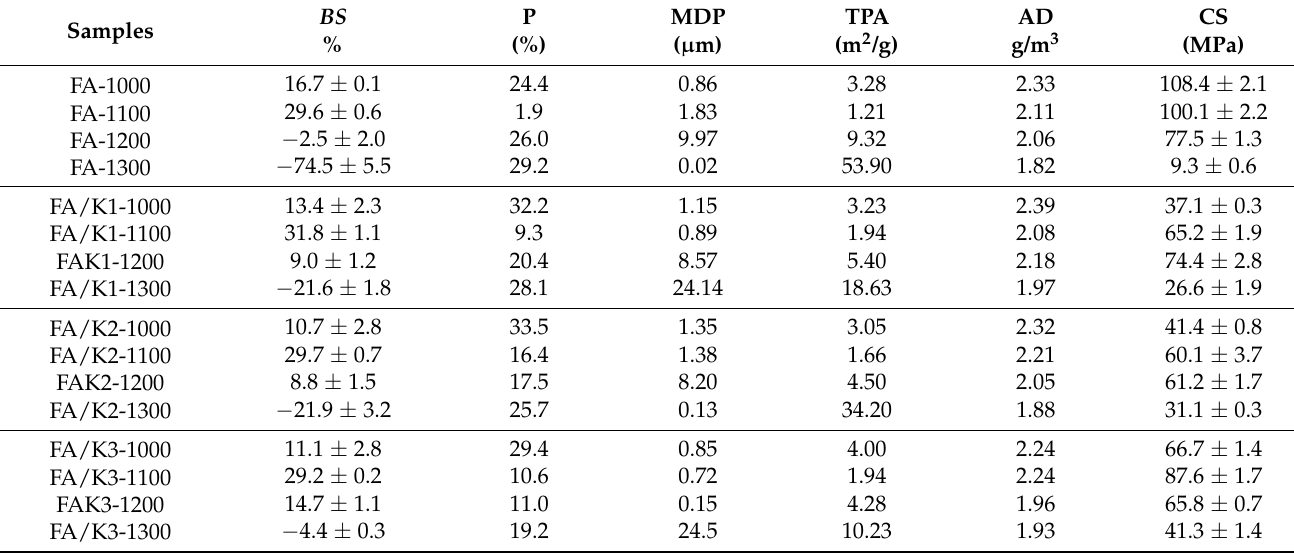
Table 4. Shrinkage, Porous Values and Compressive Strength of Annealed